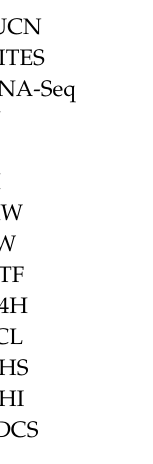
Table S1. Statistics of the results from analyzing the unigenes using multiple public databases, Figure S1. Histogram showing the distribution of the unigenes in Gene Ontology (GO) functional categories, Figure S2. Classification of the unigenes into Orthologous groups, Figure S3. Functional classification and pathway assignment of the unigenes via the use of KEGG, Figure S4. Expression levels of di ff erentially expressed genes in D and H